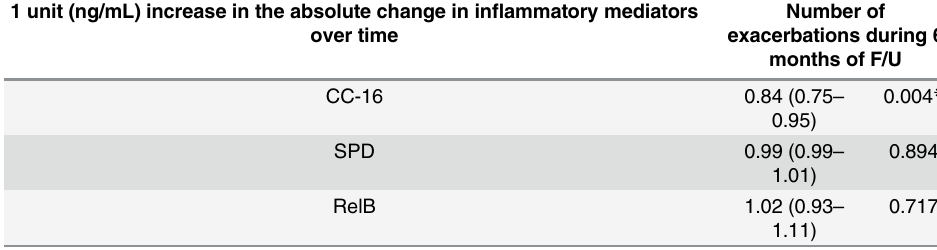
Poisson regression models were used to estimate relative risks of exacerbations. RR adjusted for baseline age, sex, and FEV1%